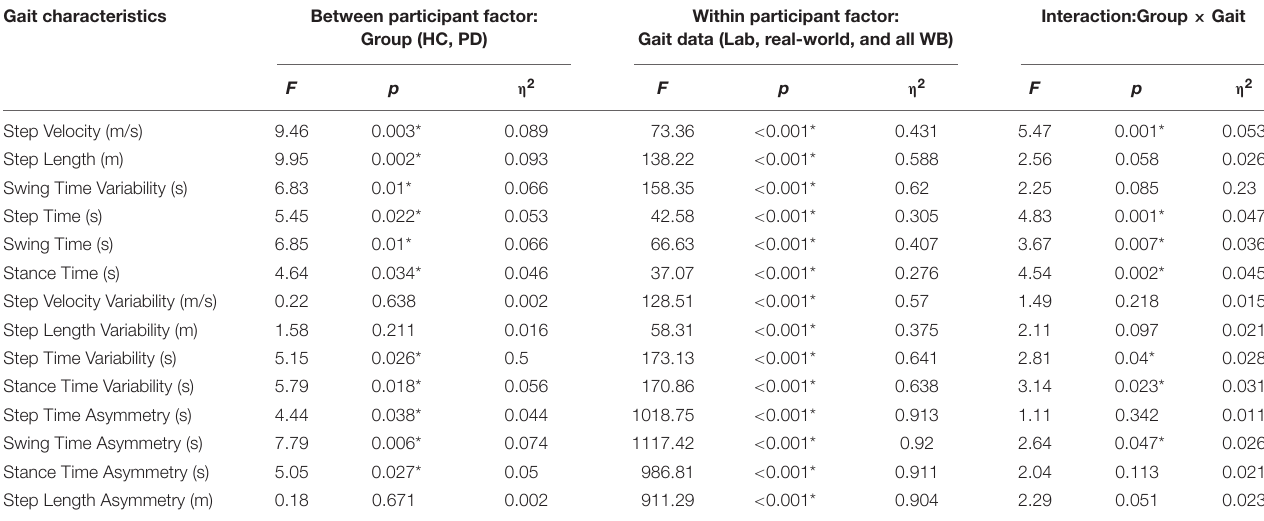
TABLE 2 | Mixed ANOVA results: main effects and interactions between gait assessment environmental conditions (lab vs. real-world) and groups (PD vs. HC) for each gait characteristic. Gait characteristics Between participant factor: Within participant factor: Interaction:Group × Group (HC, PD) Gait data (Lab, real-world, and all WB)